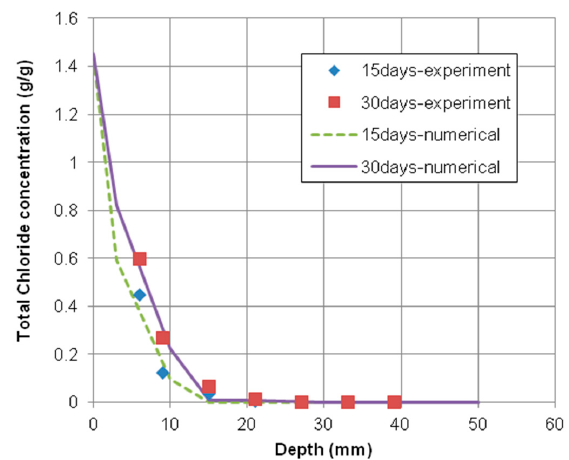
Figure 3. Chloride profiles of concrete specimen with 0.55 water–cement ratio. Exposed for 15 days and 30 days.